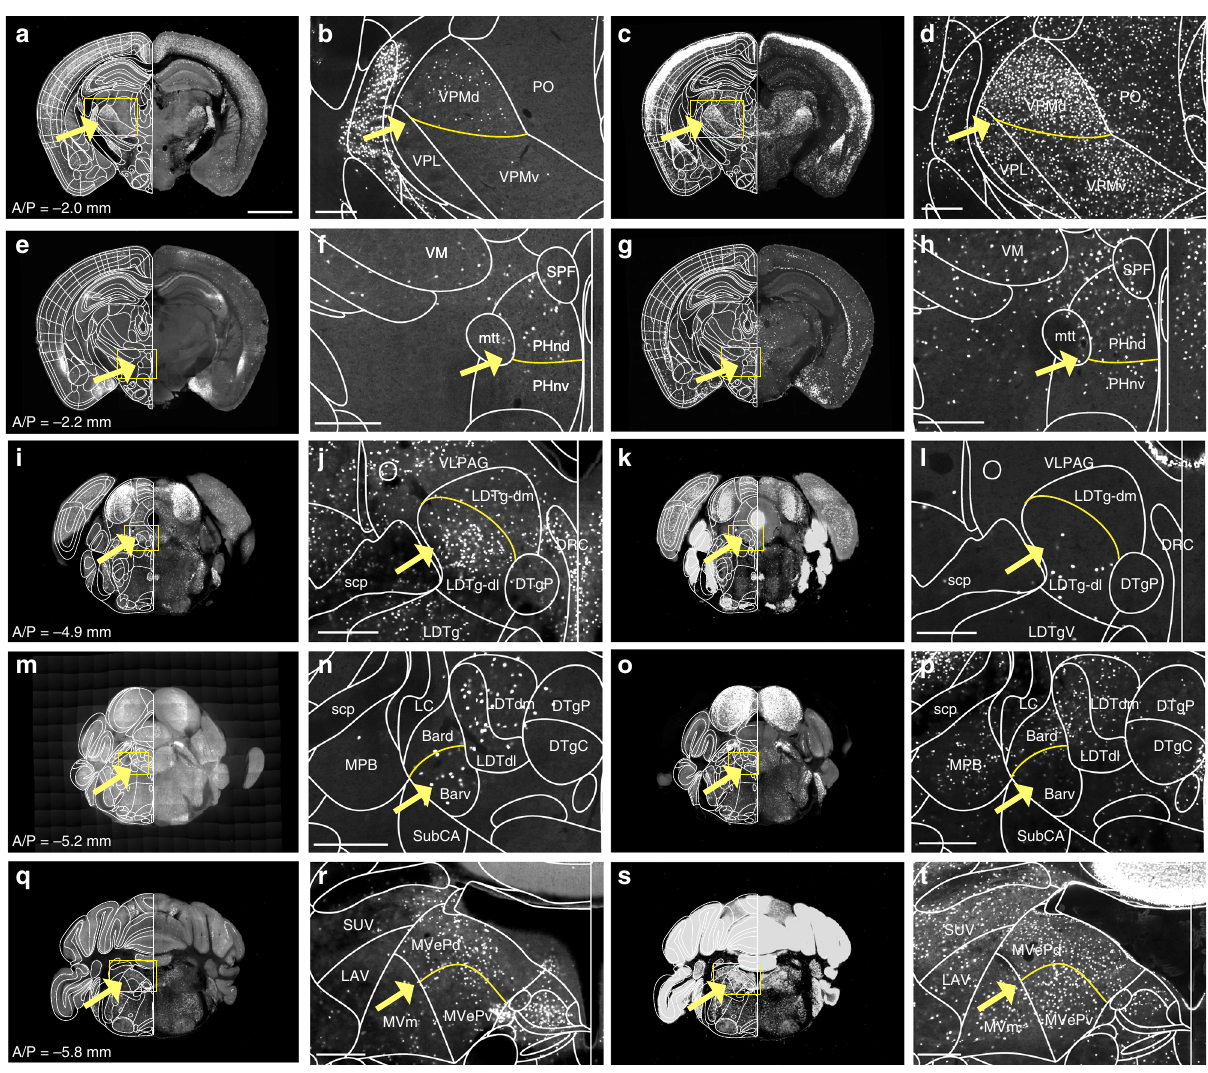
A/P = –5.8 Fig. 3 Additional segmentations based on marker brains. a – t Examples of marker brains to further segment structures de fi ned as a single structure in the FP label. Added segmentations are marked by yellow lines. a – d PV-Cre:H2B-GFP ( a , b ) and Cux2-Cre:Ai75 ( c , d ) marker brains were utilized to further segment ventral posteromedial nucleus of the thalamus (VPM) to dorsal and ventral parts (VPMd and VPMv, respectively). e – h OTR-Cre:Ai14 ( e , f ) and Ctgf-Cre:Ai75 ( g , h ) used to segment dorsal and ventral parts (PHnd and PHnv, respectively) of the posterior hypothalamic nucleus (PHn). i – l SST-Cre: H2B-GFP ( i , j ) and PV-Cre:H2B-GFP ( k , l ) used to segment laterodorsal tegmental nucleus, dorsal part (LDTg) into lateral and medial divisions (LDTg-dl and LDTg-dm, respectively). m – p Chat-Cre:Ai75 ( m , n ) and SST-Cre:H2B-GFP ( o – p ) used to segment Barrington nucleus (Bar) into dorsal and ventral parts (Bard and Barv, respectively). q – t SST-Cre:H2B-GFP ( q , r ) and PV-Cre:H2B-GFP ( s , t ) used to segment the medial vestibular nucleus, parvicellular part (MVp) to dorsal and ventral parts (MVpd and MVpv, respectively). See Supplementary Data 2 for full names of abbreviations. Scale bars in fi rst